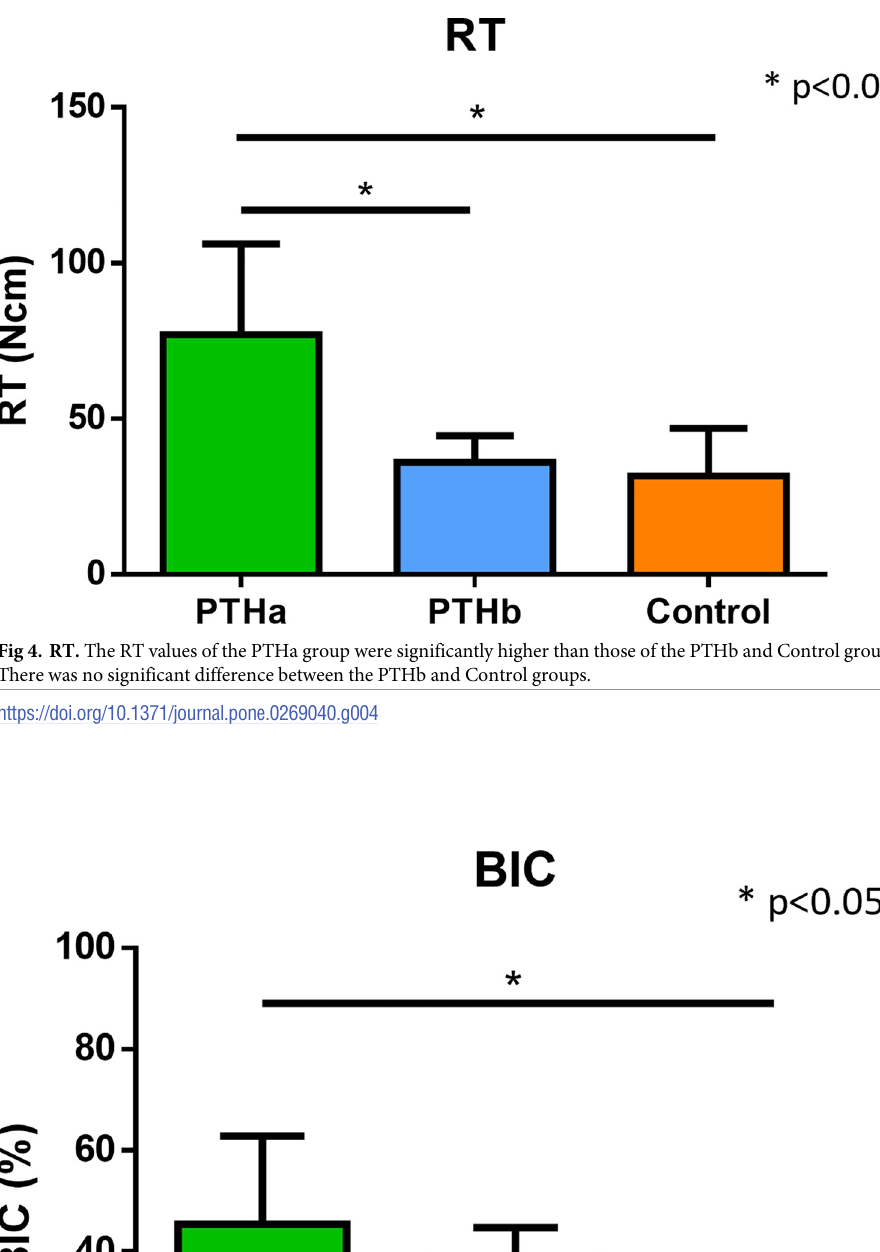
PLOS ONE | https://doi.org/10.1371/journal.pone.0269040 June 8,